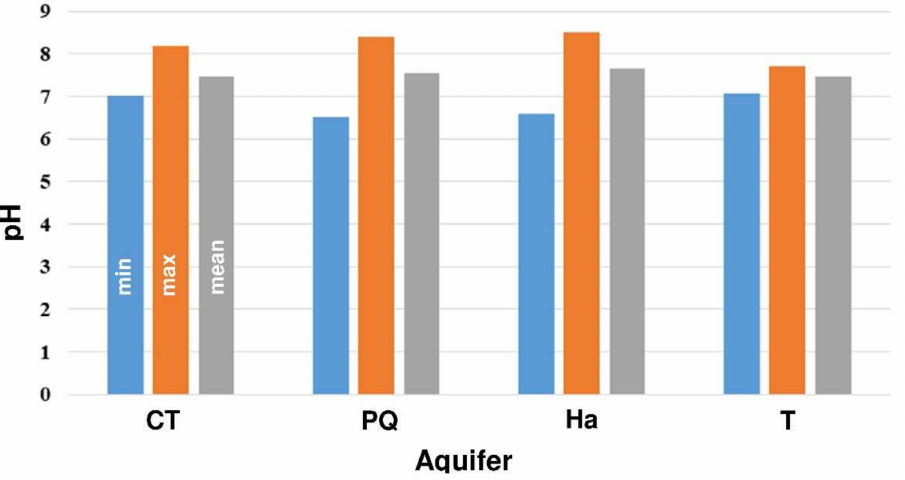
Figure 12. pH variation in the aquifers (2020 campaign). CT stands for Cenomano-Turonian, PQ stands for Plio-Quaternary, Ha stands for Hauterivian, and T stands for Turonian.